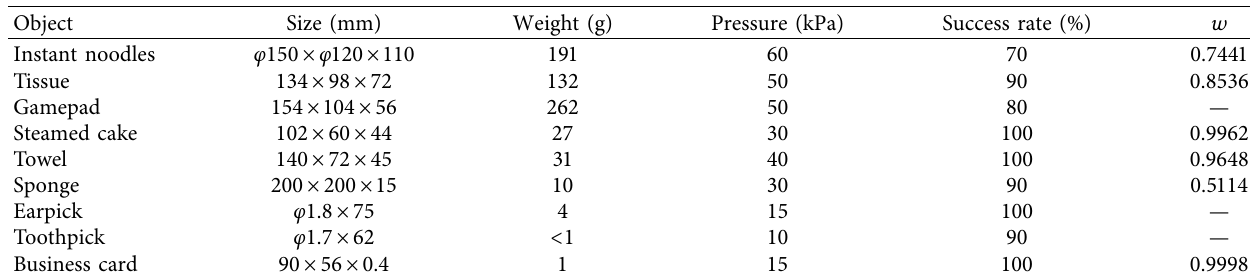
Figure 17: Grasping experiment. (a) Instant noodles. (b) Tissues. (c) Gamepad. (d) Steamed cake. (e) Towel. (f) Sponge. (g) Earpick. (h) Toothpick. (i) Business card. Table 6: The success rate of